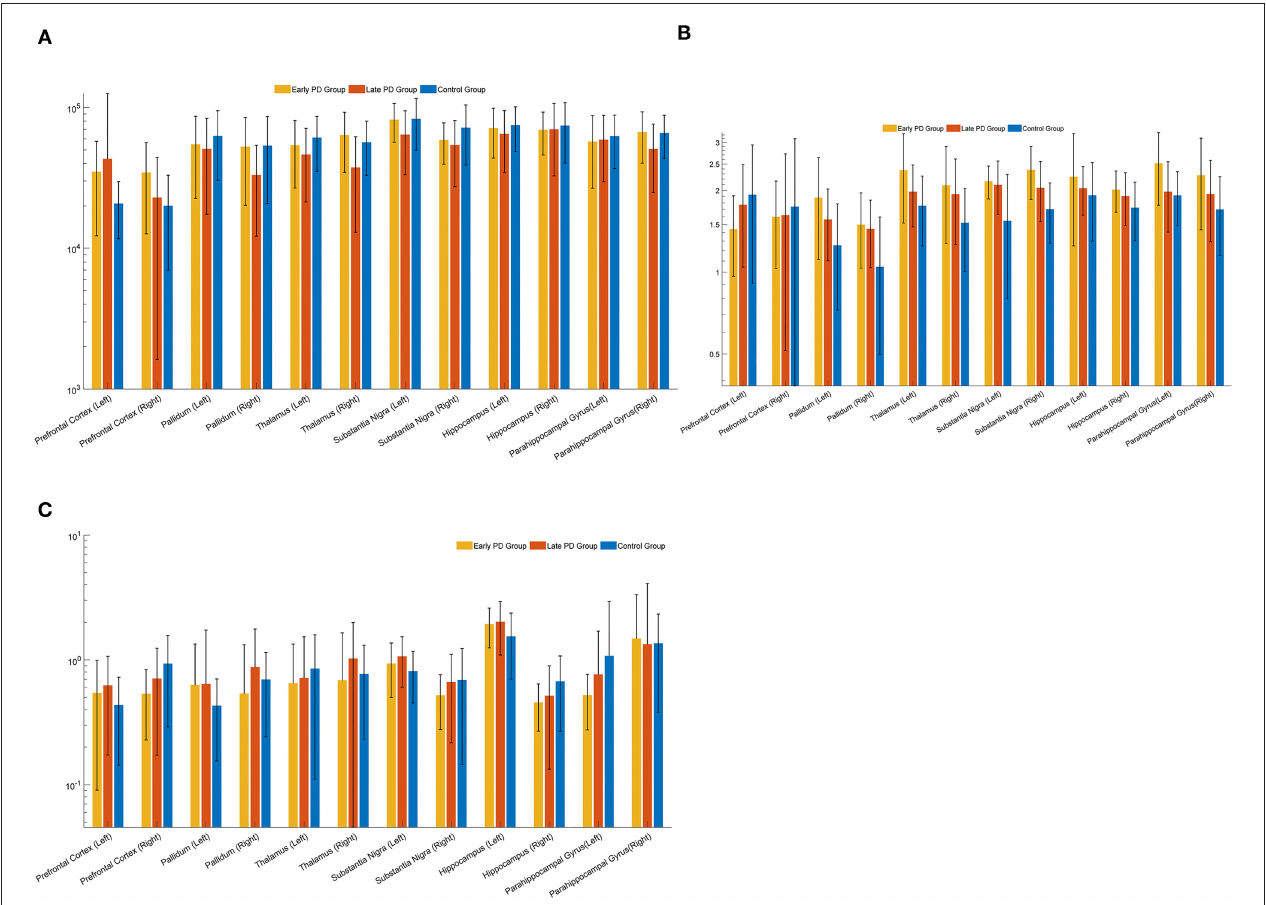
FIGURE 3 | Error bars of mean and standard deviation values of creatine (Cr) (A) , N-acetyl aspartate-to-creatine (NAA/Cr) (B) , and myo-Inositol-to-creatine (mI/Cr) (C) , at different sites in the early, late PD group, and the control group.